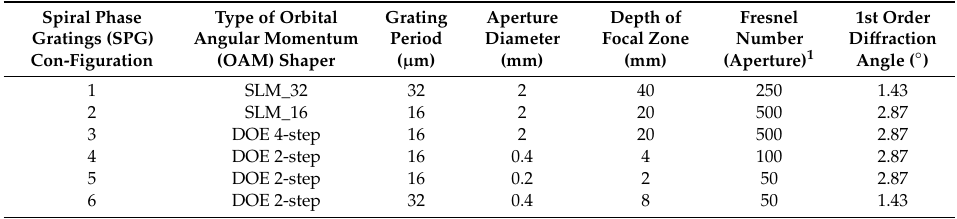
Table 1. Geometrical parameters of spiral phase gratings used as orbital angular momentum (OAM) beam shapers.